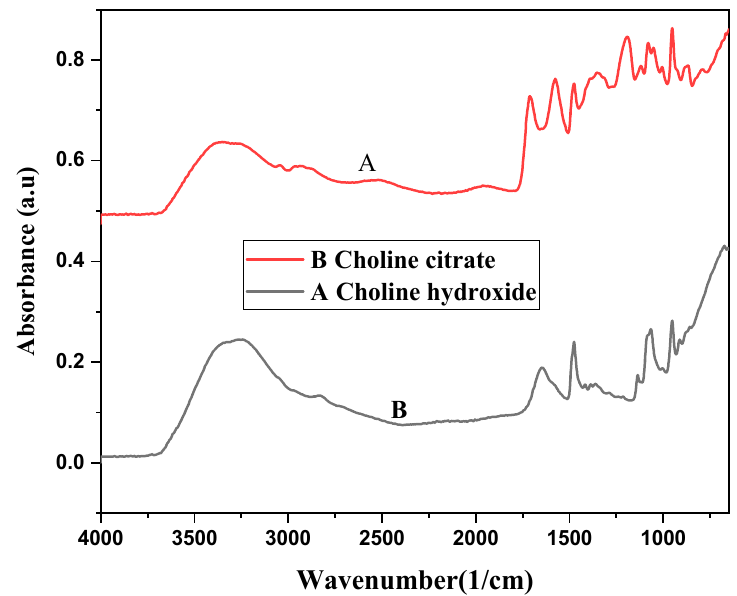
Figure 2. FTIR spectra of choline hydroxide (A) and choline citrate gels (B).